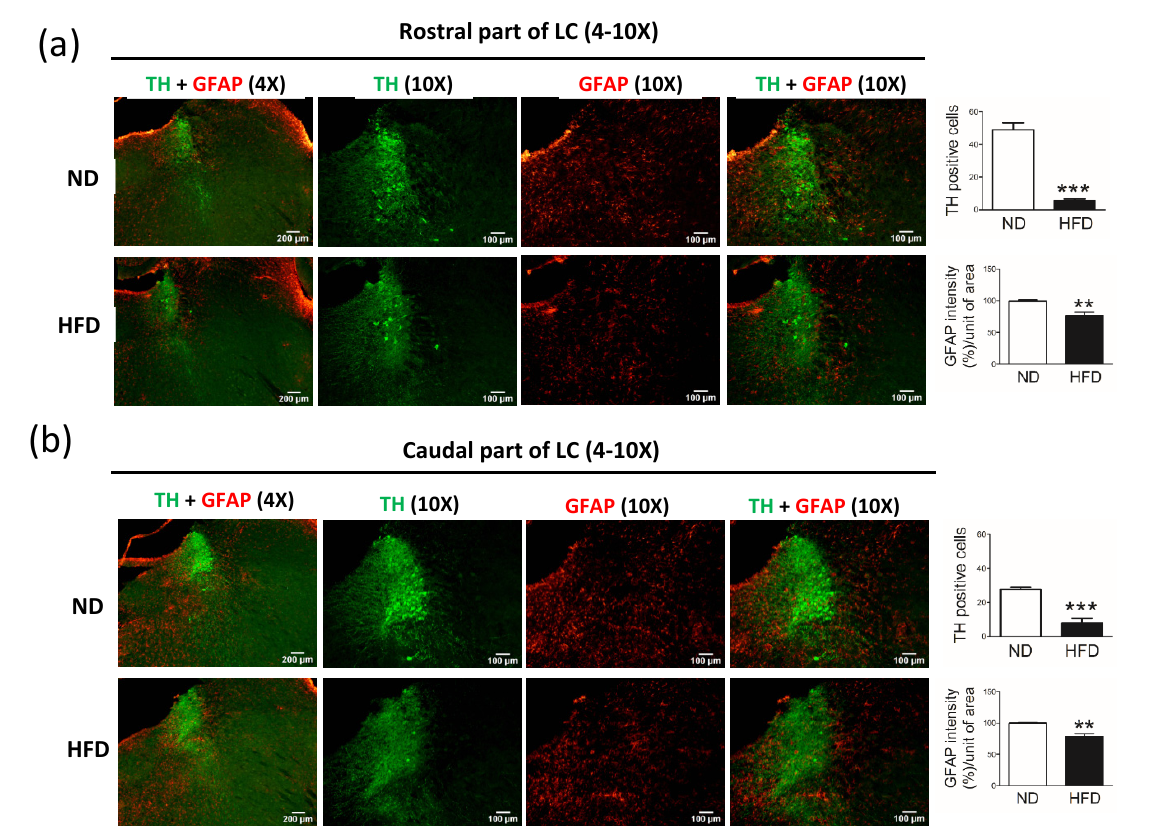
Figure 6. Immunostaining of astrocytes (GFAP-positive cells) and norepinephrine neurons (tyrosine hydroxylase [TH]-positive cells) in the locus coeruleus (LC) after middle-aged rats were fed a normal diet (ND, control) or 45% high-fat diet (HFD) for 30 weeks. Data were captured with 4X (scale bar = 200 μ m) and 10X (scale bar = 100 μ m) objectives. Immunostaining for TH-positive cells (norepinephrine neurons) and GFAP-positive cells (astrocytes) in the ( a ) rostral part of the LC and the ( b ) caudal part of the LC. As shown on the right, the GFAP immuno-intensity (%) and TH-positive cells per unit of area (10X objective, n = 4) were quantified by using cellSens Dimension software (Olympus). Data are expressed as the mean ± SEM. ** p < 0.01, *** p < 0.001 between groups ( t -test).